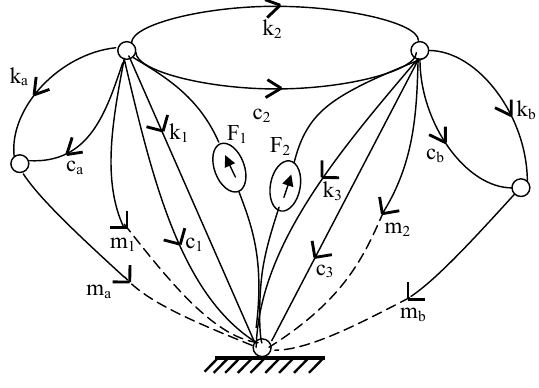
Fig. 6. Linear graph of system of two masses with two